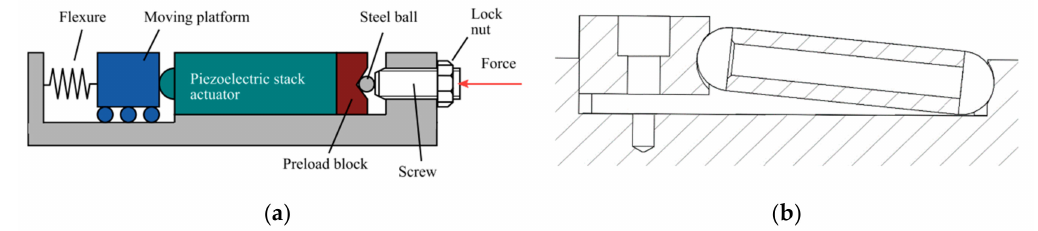
Figure 6. Preload mechanism: ( a ) mechanical [20]; ( b ) by interference (selected